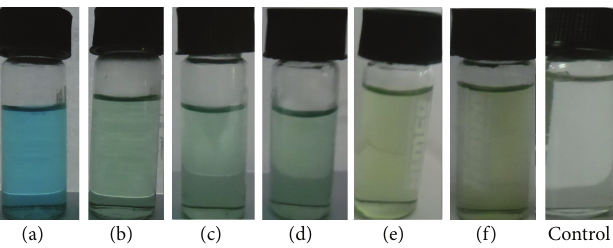
Figure 8: Visual observation of color change from blue to colorless indicates degradation of methylene blue dye at different time intervals